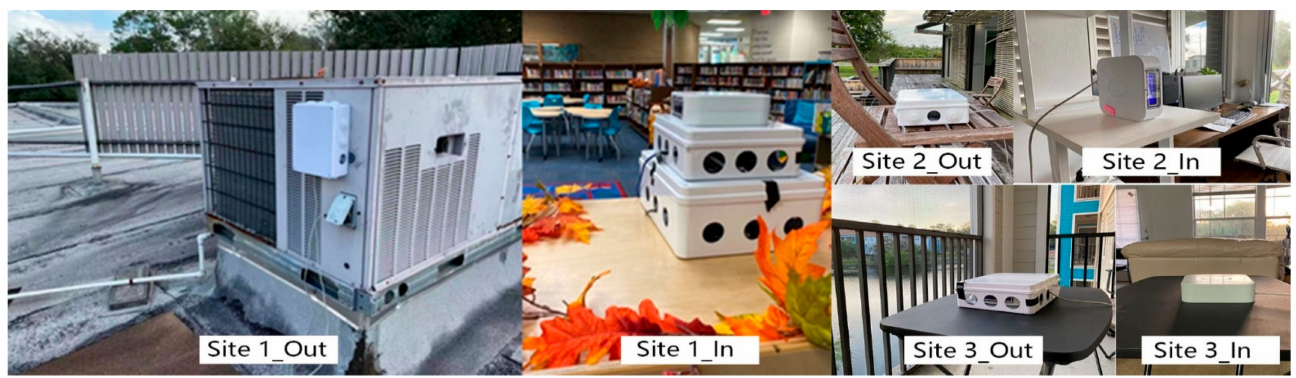
Figure 1. Photos of field